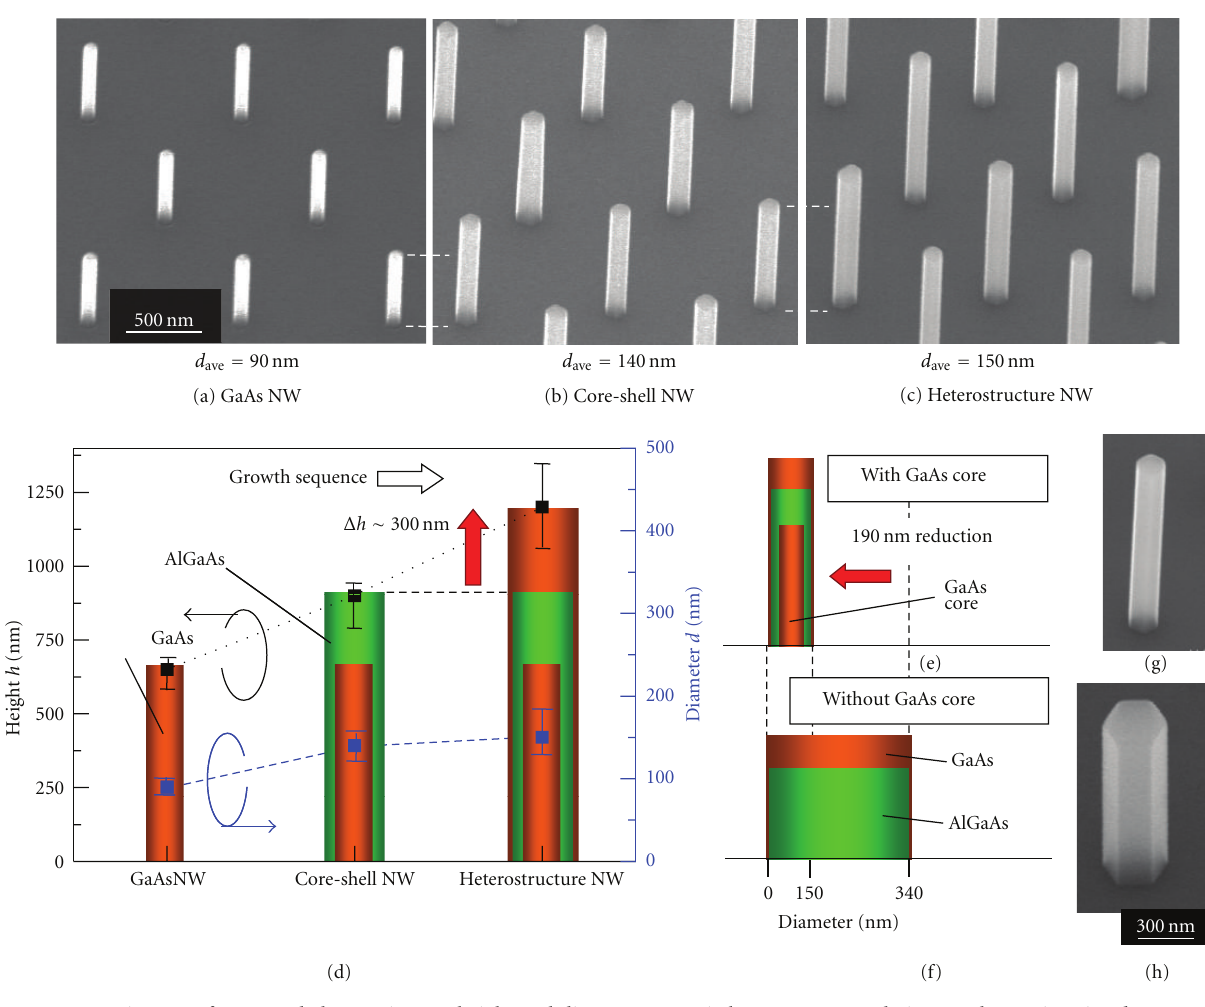
Figure 7: SEM images of NWs and changes in NW height and diameter. NW pitch a = 1 . 0 μ m and SiO 2 mask opening size d 0 = 80 nm. (a), (b), and (c) correspond to SEM images for GaAs NWs, core-shell NWs, and heterostructure NWs. White dotted parallel lines bridged between SEM images (a) and (b), or (b) and (c) clarify how NW height changed between growth steps. (d) Changes in height and diameter of NWs corresponding to growth steps of GaAs NW (GaAs core growth time: 5 min), GaAs/AlGaAs core-shell NW (AlGaAs shell growth time: 2.5 min), and GaAs/AlGaAs/GaAs heterostructure NW (top GaAs growth time: 2min). (e) and (f) illustrate reduced NW diameter by introducing GaAs core. (g) and (h) are SEM images of NW grown with and without GaAs core, corresponding to schematics in (e) and (f). Growth time for AlGaAs is 20min and 5min for GaAs for structures in (f) and (h)